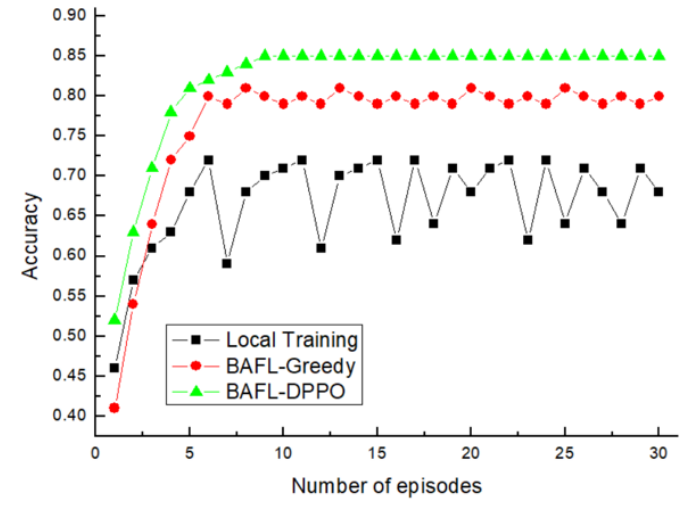
Figure 7. Accuracy comparison (30% of malicious device nodes).